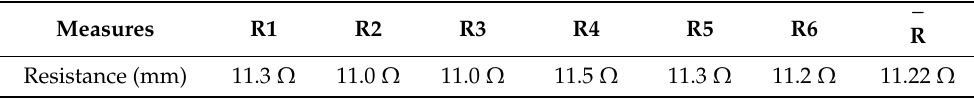
Table 2. Resistance of the Electrifi material.